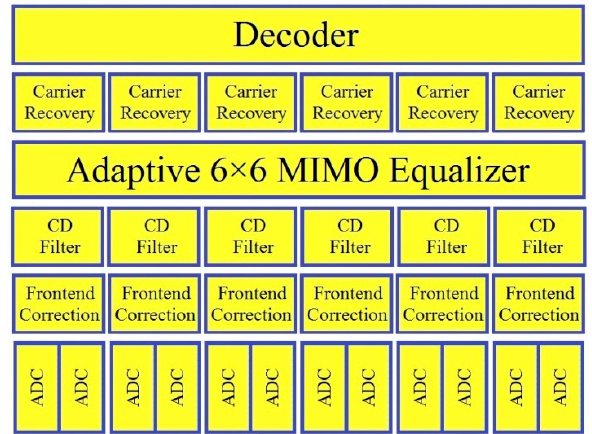
Figure 3. The typical coherent receiver configuration for a single-carrier transmission system with a 6 × 6 multi-input multi-output (MIMO) frequency-domain equalization (FDE) [7].